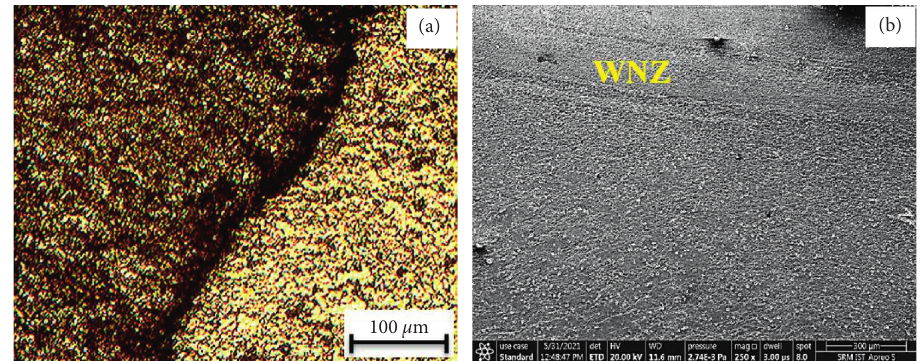
Figure 8: (a) Optical microimage of nugget center region. (b) FESEM micrograph of nugget top region.